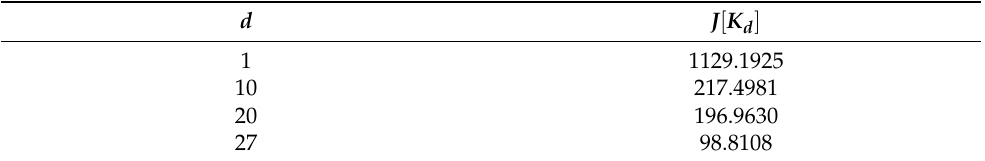
Table 5. Solution results for different mini-batch